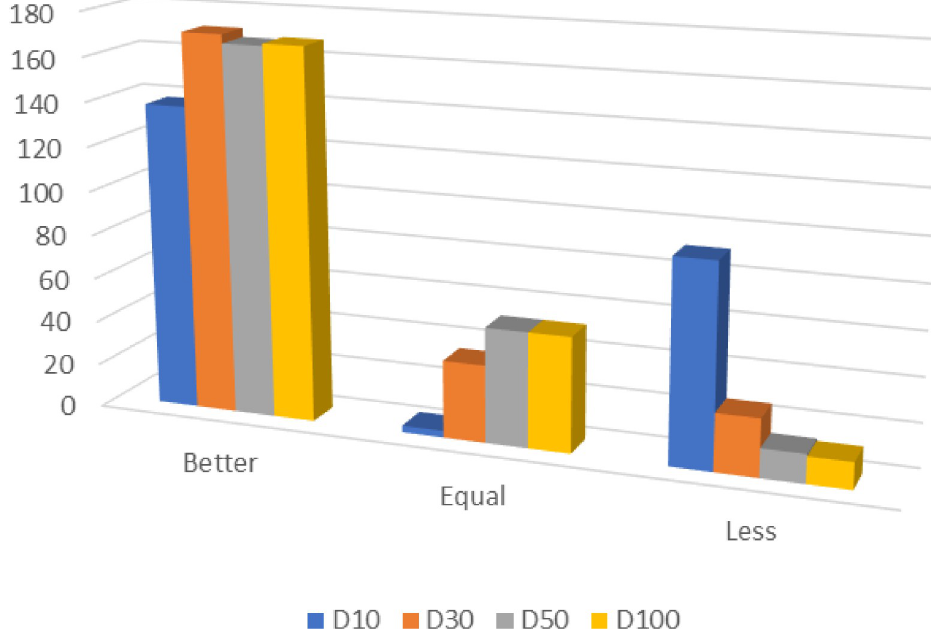
Fig 5. The comparative statistical result with growth in